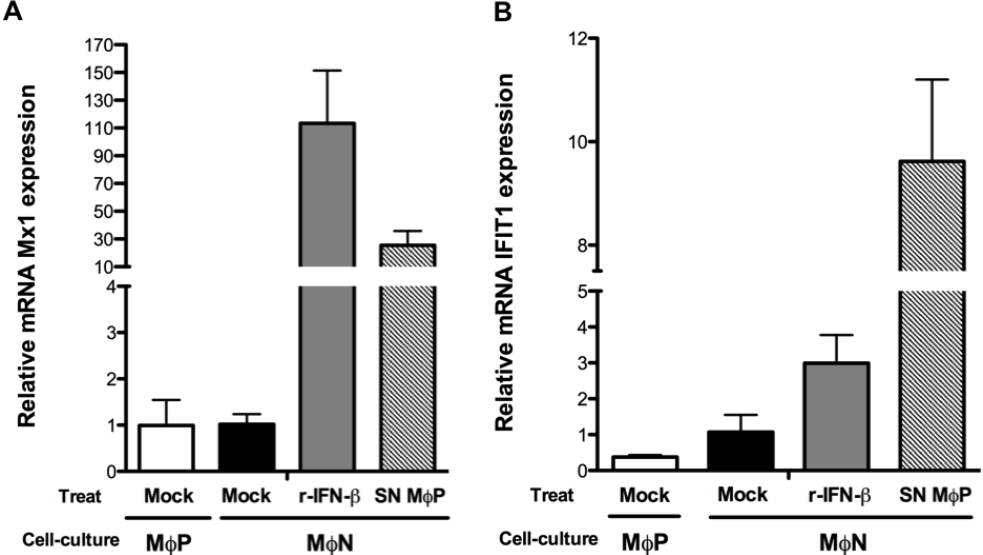
Figure 5. Mx1 and ISG56 mRNA expression level in persistently RSV-infected macrophages. Quantitative RT-PCR was performed with passages 107, 108 and 109 of mock-treated, non-infected macrophages (MΦN) and with passages 102, 103 and 104 of persistently RSV-infected macrophages (MΦP), to determine mRNA expression level of Mx1 ( A ) and ISG56 ( B ) by the ΔC t method. Also, MΦN were treated with 100 U/mL of recombinant-IFN-β (r-IFN-β) or supernatants from passages 87, 90 and 96 of MΦP (SN MΦP) for 45 min. Subsequently, Mx1 and ISG56 gene expression was evaluated. The values from the three different passages were averaged and plotted as relative expression of each gene. Treat: treatment. Results were reproduced in six cellular passages analyzed (biological replicates).